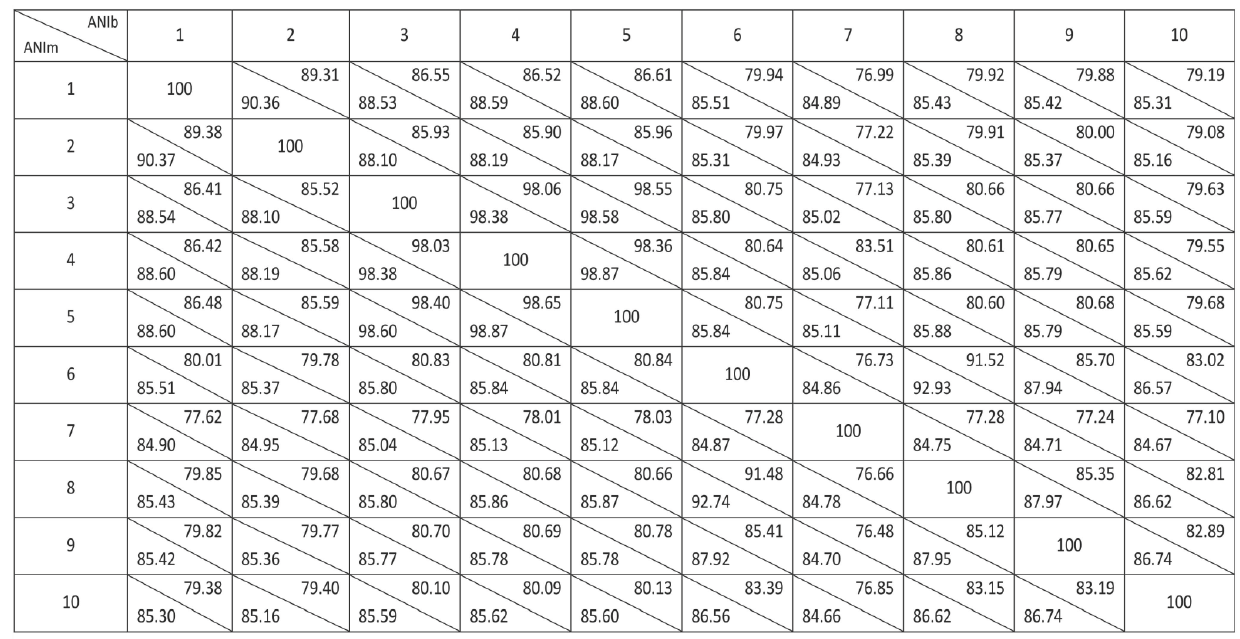
Figure 6. Pairwise genome comparison of Pseudomonas sp., strain L5B5, and closest relatives by means of Average Nucleotide Identity using BLAST (ANIb) and MUMmer (ANIm). 1: Pseudomonas